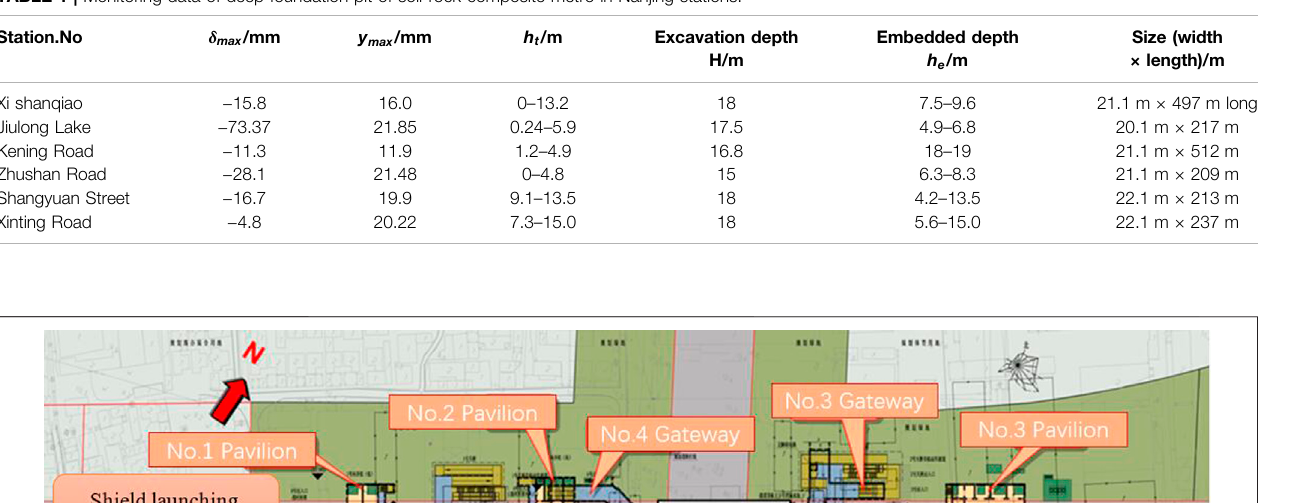
0.4 ‰ H , as described in Figure 6A . The red line in Figure 5 represent the case of the deeper soil embedded depth ( > 15 m). The corresponding maximum horizontal displacement values of support piles are mostly between 0.2 ‰ H – 2.6 ‰ H with an average value of 1.4 ‰ H , as illustrated in Figure 6B .